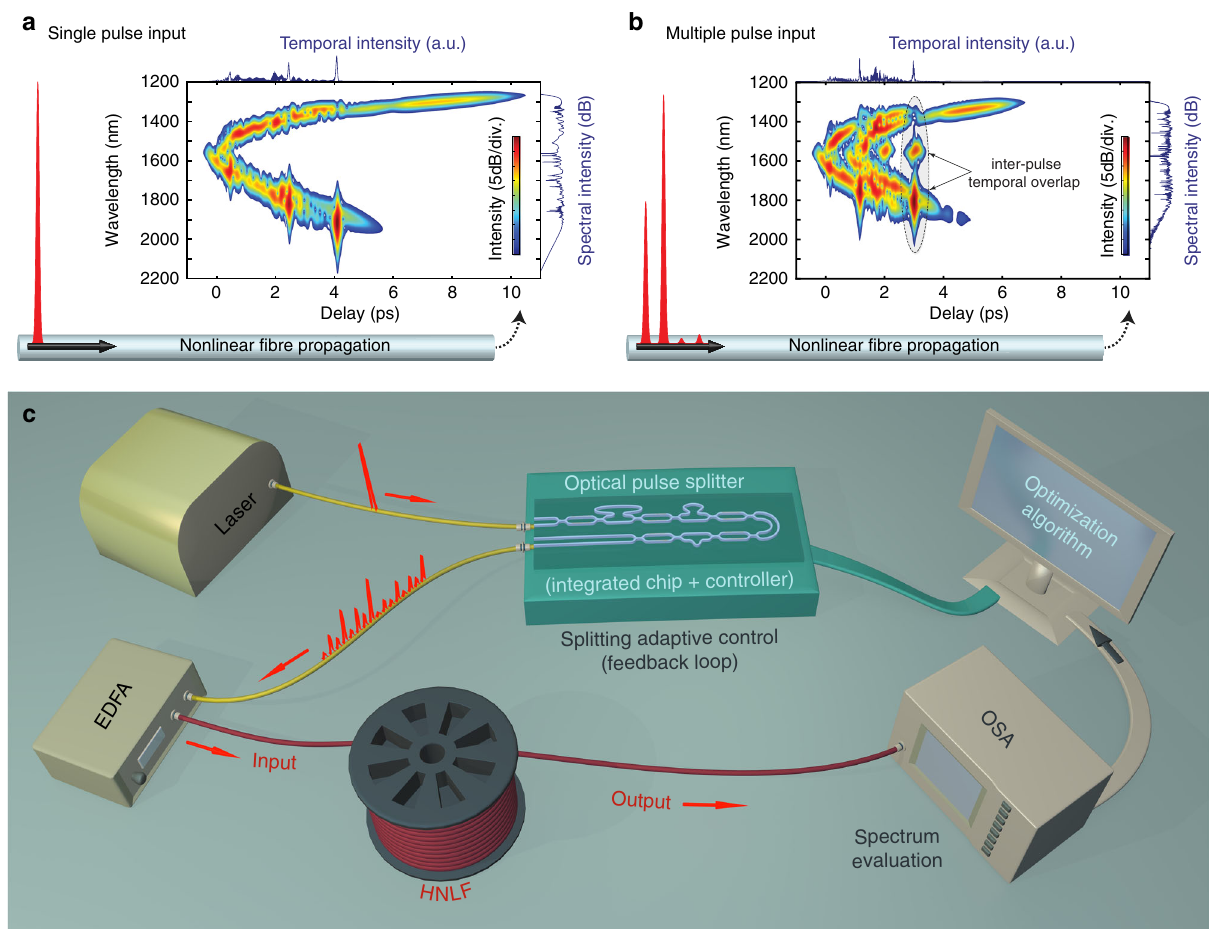
Fig. 1 Concept of supercontinuum spectral customization via multiple pulse seeding. a Example of spectro-temporal properties (spectrogram 53 ) of a single sub-picosecond pulse after propagation in a nonlinear optical fi bre (see Methods). The newly-created spectral components experience progressive temporal walk-off 9,30 . At a given distance, only a few of the components temporally overlap, limiting nonlinear effects to intra-pulse interactions and restricting spectral shaping capabilities. b Using several pulses, more complex intra- and inter-pulse dynamics can be excited. Pulse-to-pulse separations on the order of the temporal walk-offs (~ps), enable the interplay of various spectral components generated from different pulses, thus providing enhanced nonlinear control over the spectral shaping. c Experimental setup: An integrated pulse-splitter is used to generate a custom train of pulses with ps- separation. After ampli fi cation with an erbium-doped fi bre ampli fi er (EDFA), these are injected into a 1 km-long, highly-nonlinear fi bre (HNLF) to form a supercontinuum, monitored using an optical spectrum analyser (OSA). A feedback loop is used to optimize the seed pulse train and tailor